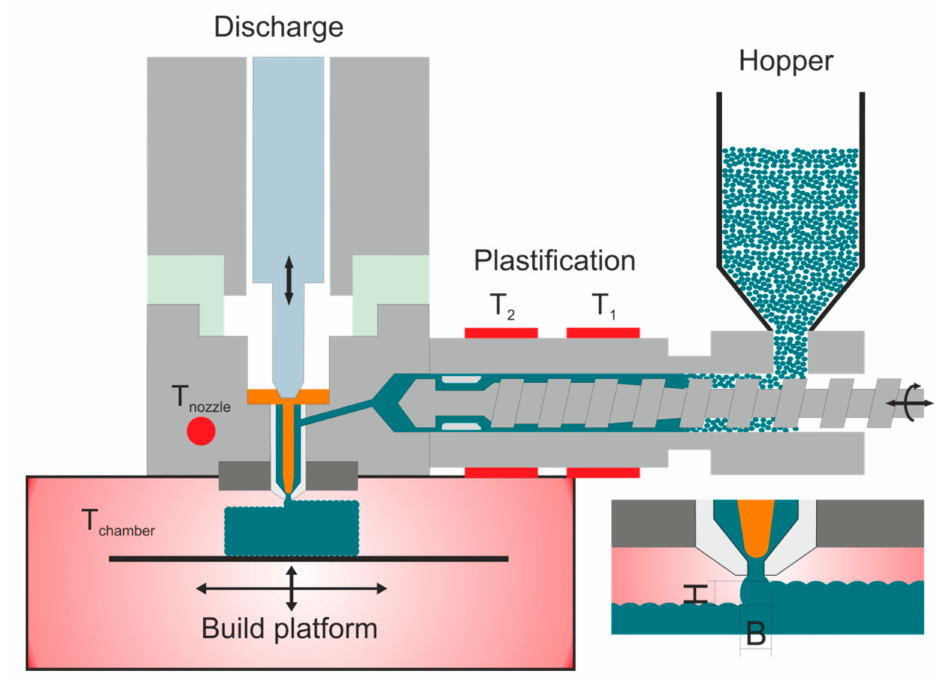
Figure 1. Working principle of Arburg Plastic Freeforming process where T 1 is the temperature in cylinder zone 1, T 2 is the temperature in cylinder zone 2, T nozzle is the nozzle temperature, and T chamber is the chamber temperature. B and H are the width and height of the produced droplets,